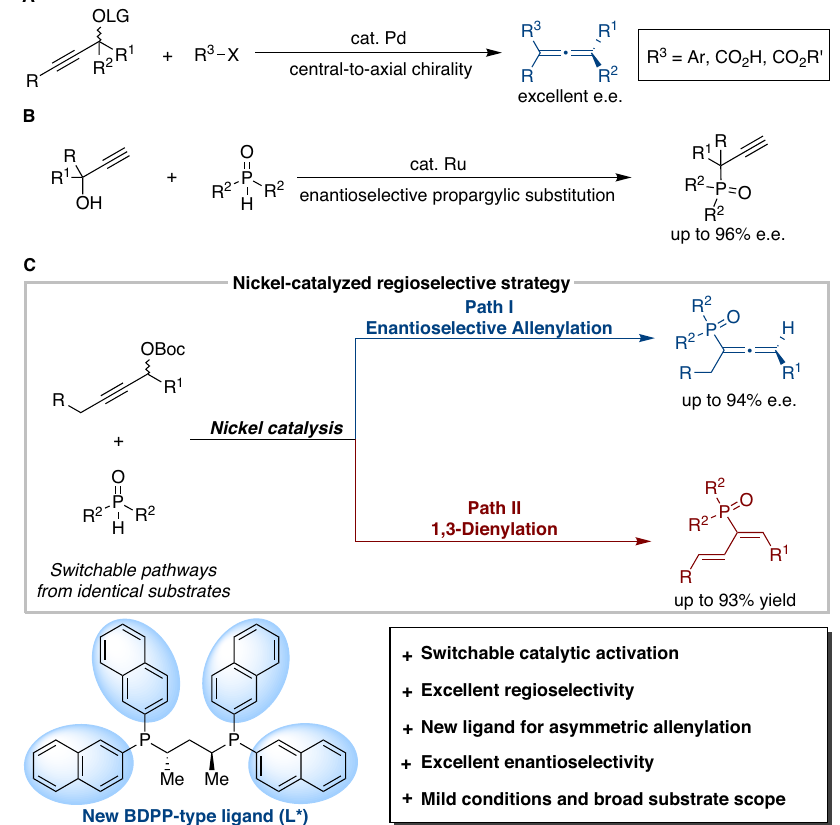
Fig. 1 | Nickel-catalyzed regioselective strategy for 1,3-dienylation and enantioselective allenylation. A Pd-catalyzed enantioselective allenylation. B Ru-catalyzed enantioselective propargylic phosphinylation. C This work: Ni-catalyzed 1,3-dienylation and enantioselective